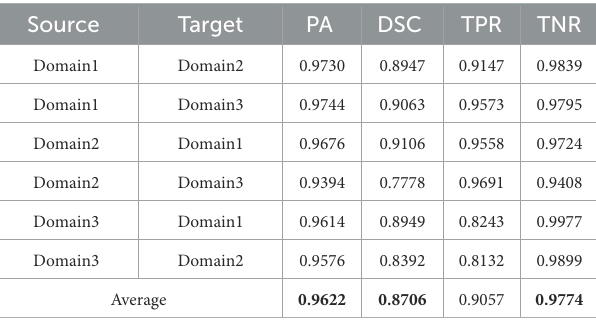
Bold values mean that the value is the best among all the comparison methods and our method.